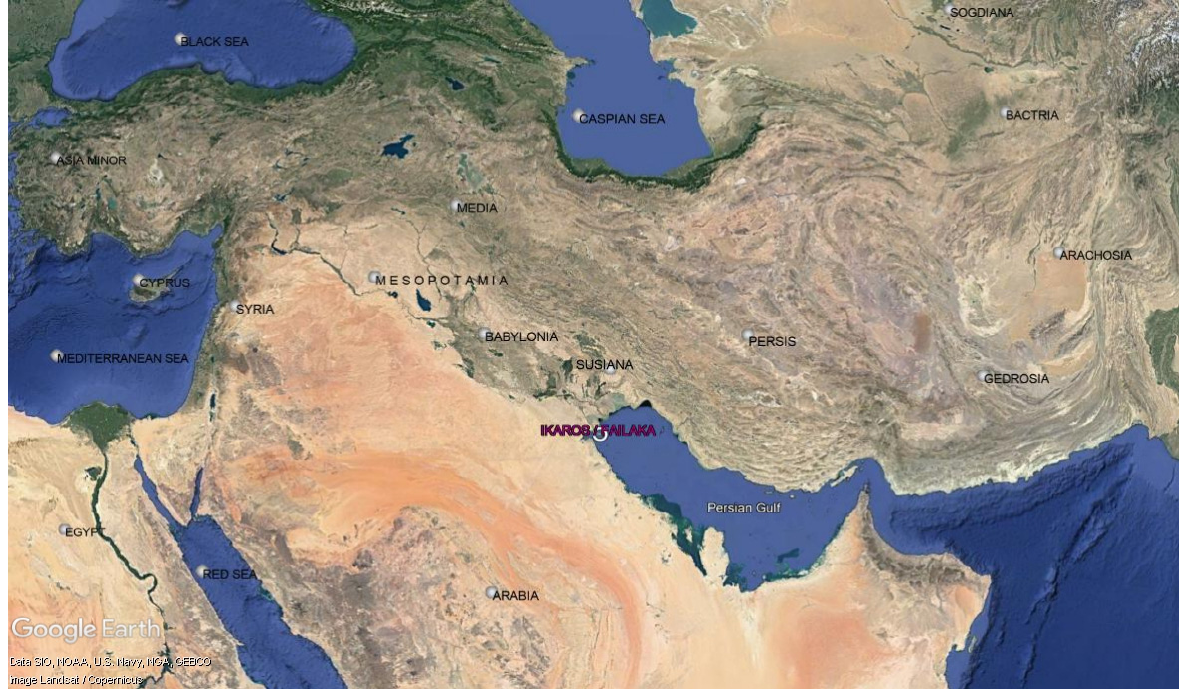
Figure 3. Map of the Middle East showing the position of Ikaros/Failaka. The map was created by the author using Google Earth Pro maps.